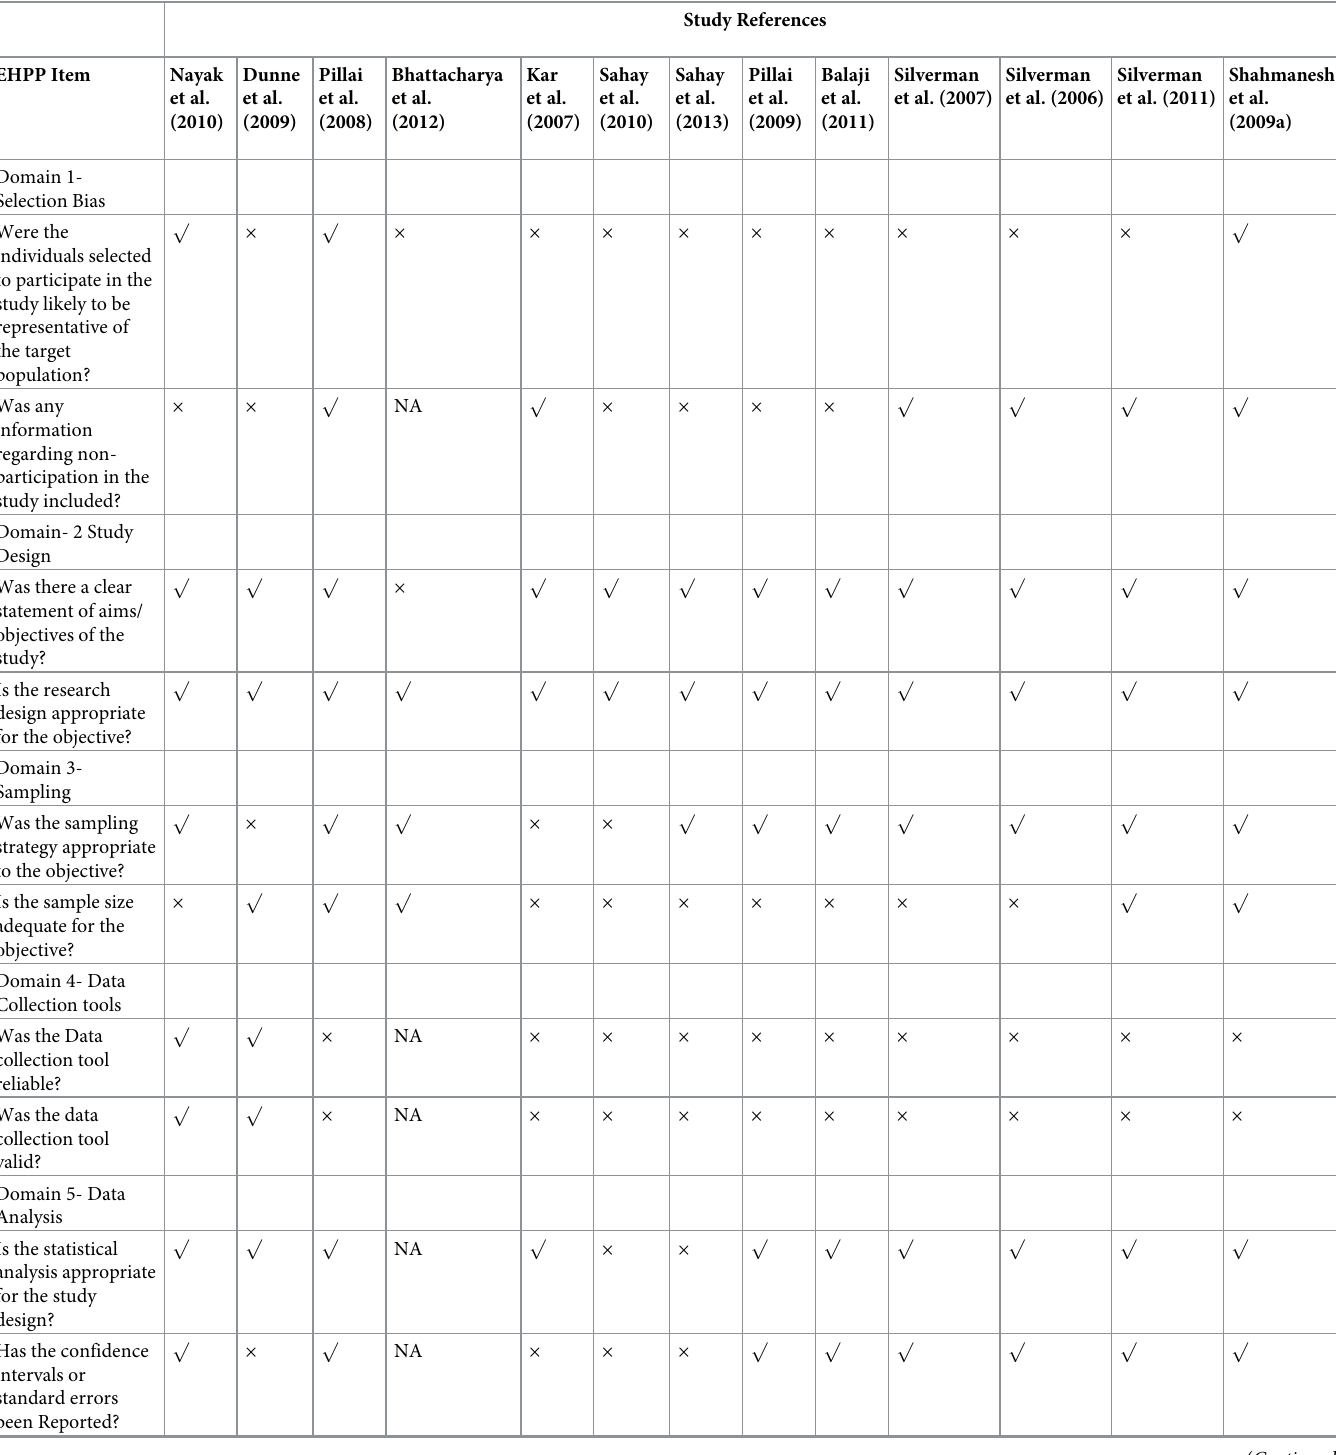
Table 12. Quality assessments of quantitative and mixed-method